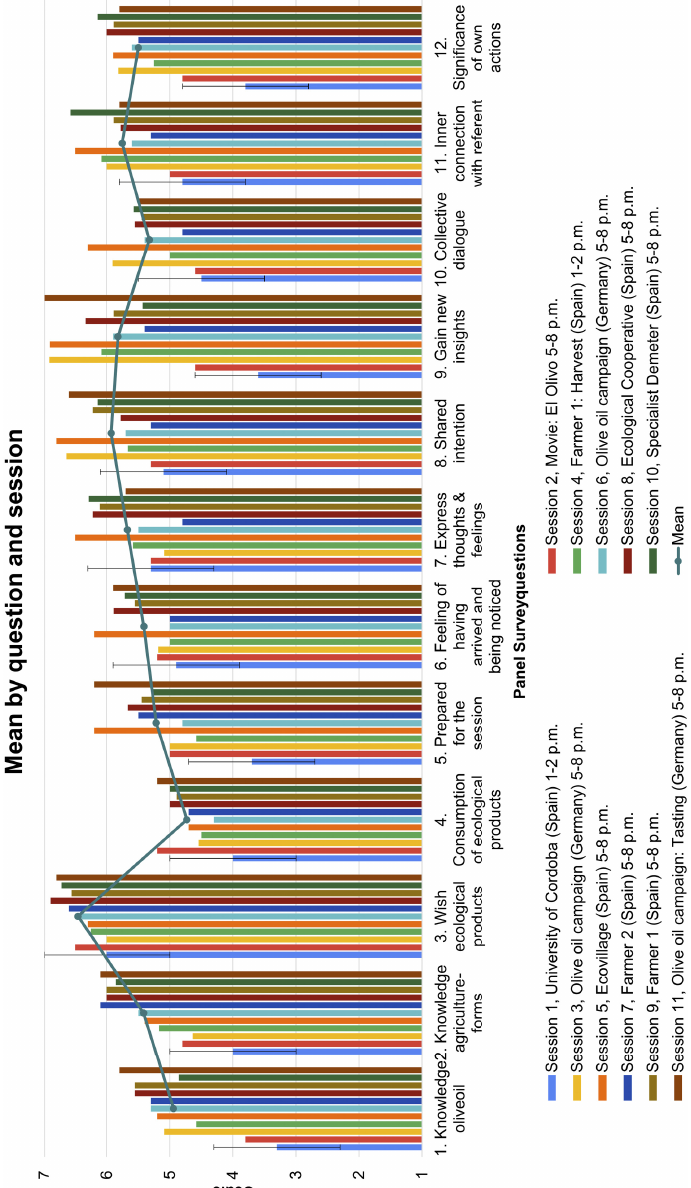
Figure 2. Resultsandprogressof online